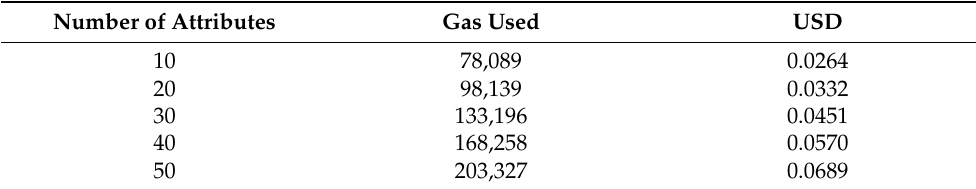
Figure 3. ( a ) Time cost of data holder; ( b ) time cost of data user; ( c ) verification time cost. Table 3. The smart contract cost of storing attribute